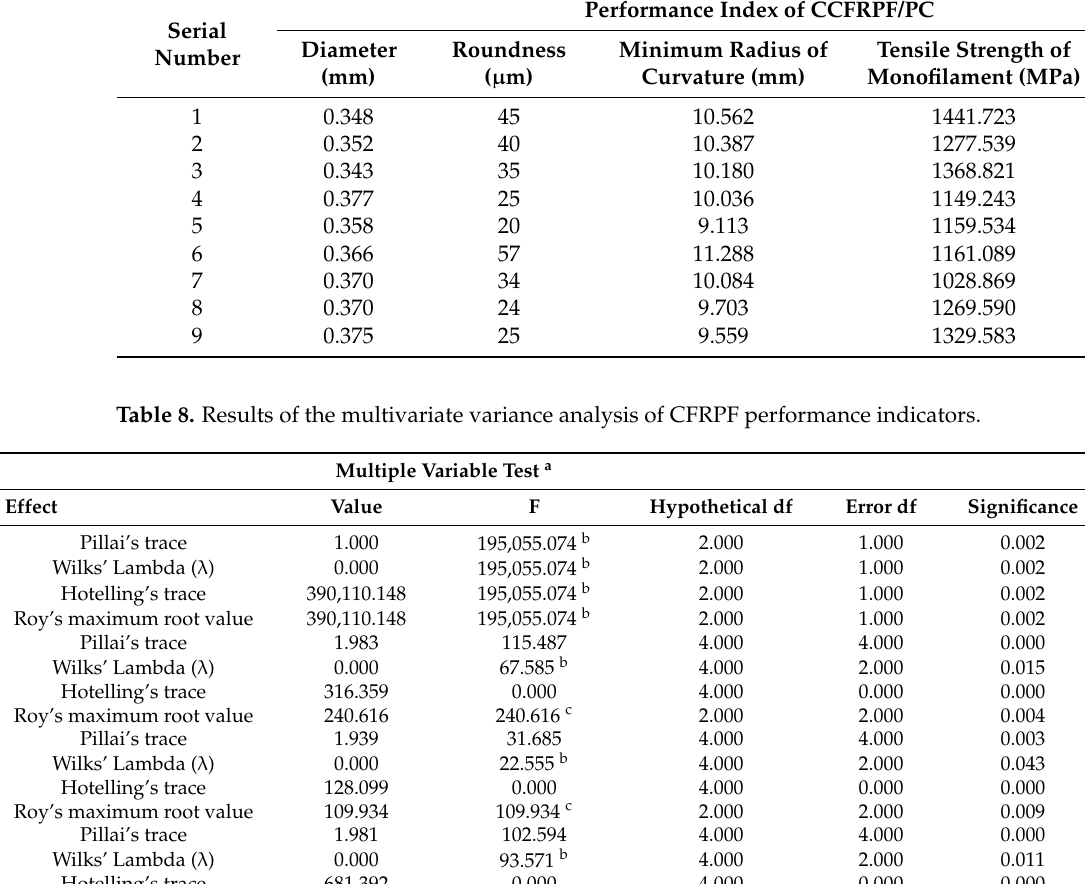
Table 7. Summary table of orthogonal test results.